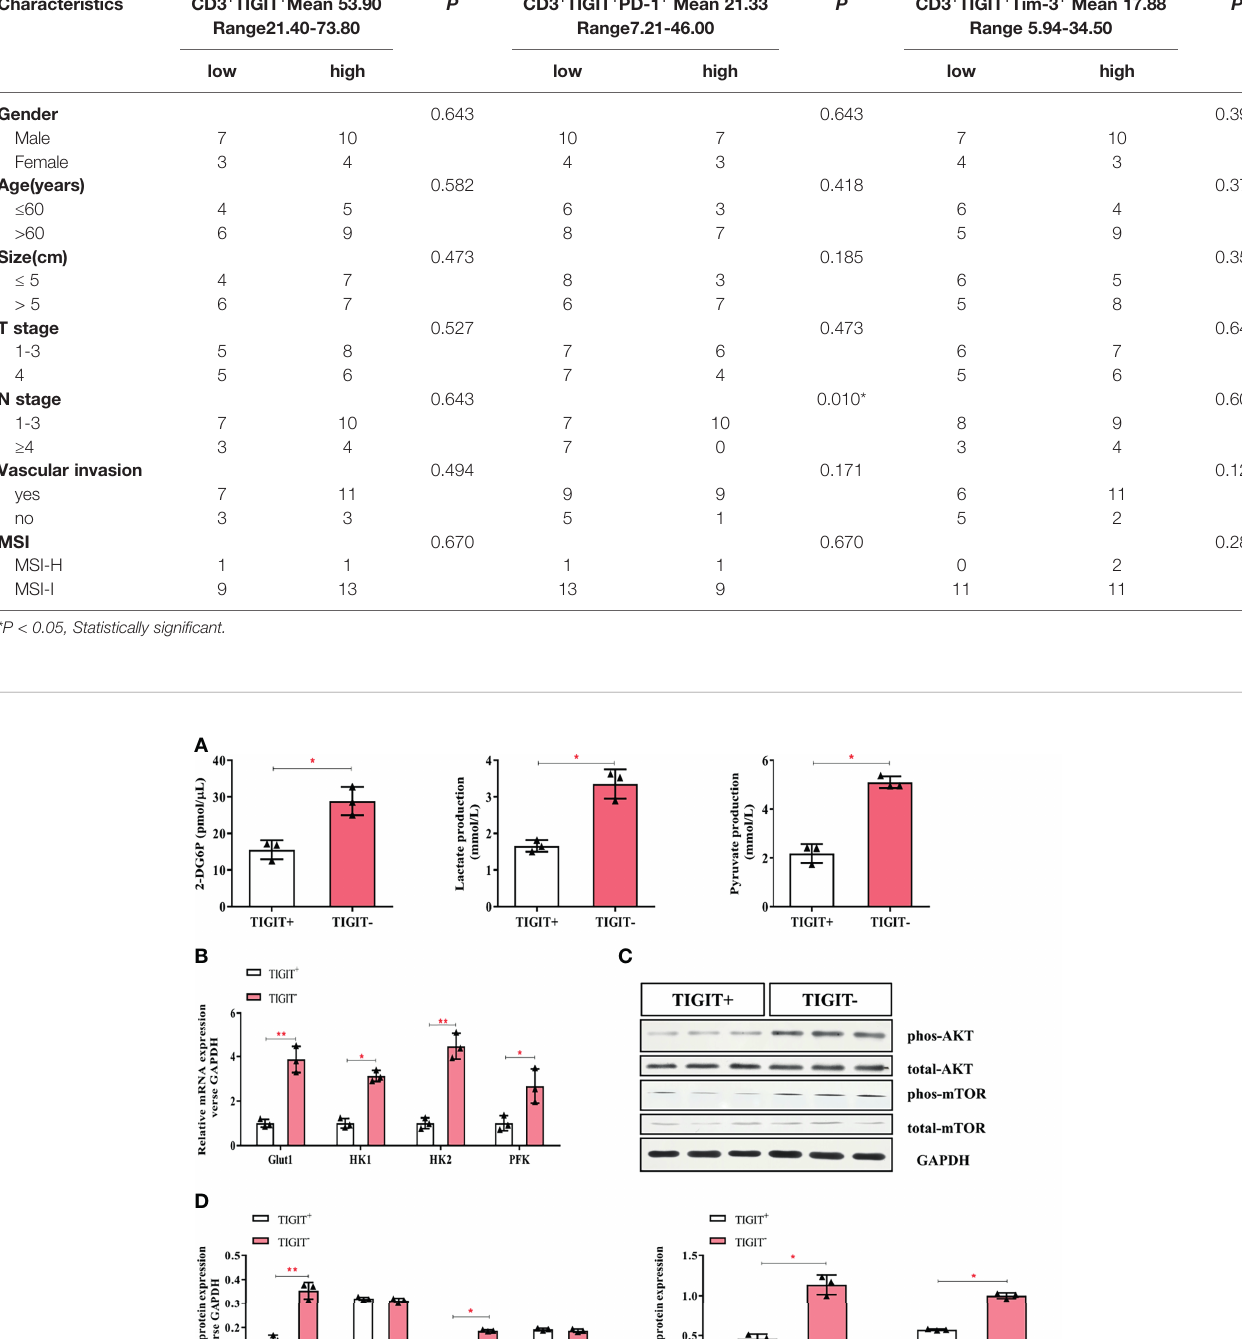
TABLE 2 | Correlations between immune markers expressions and clinic pathologic information. Characteristics